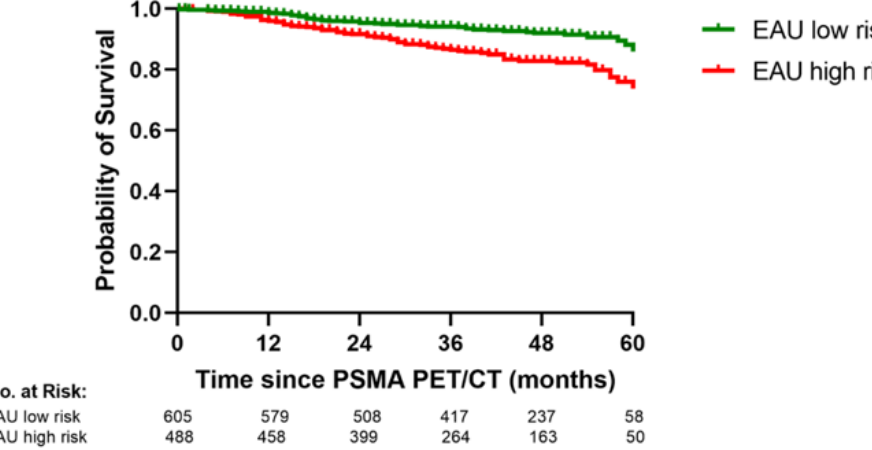
Figure 5. The EAU BCR risk classification significantly separates the patients with PSA relapse into two groups with different overall survival ( p < 0.0001).